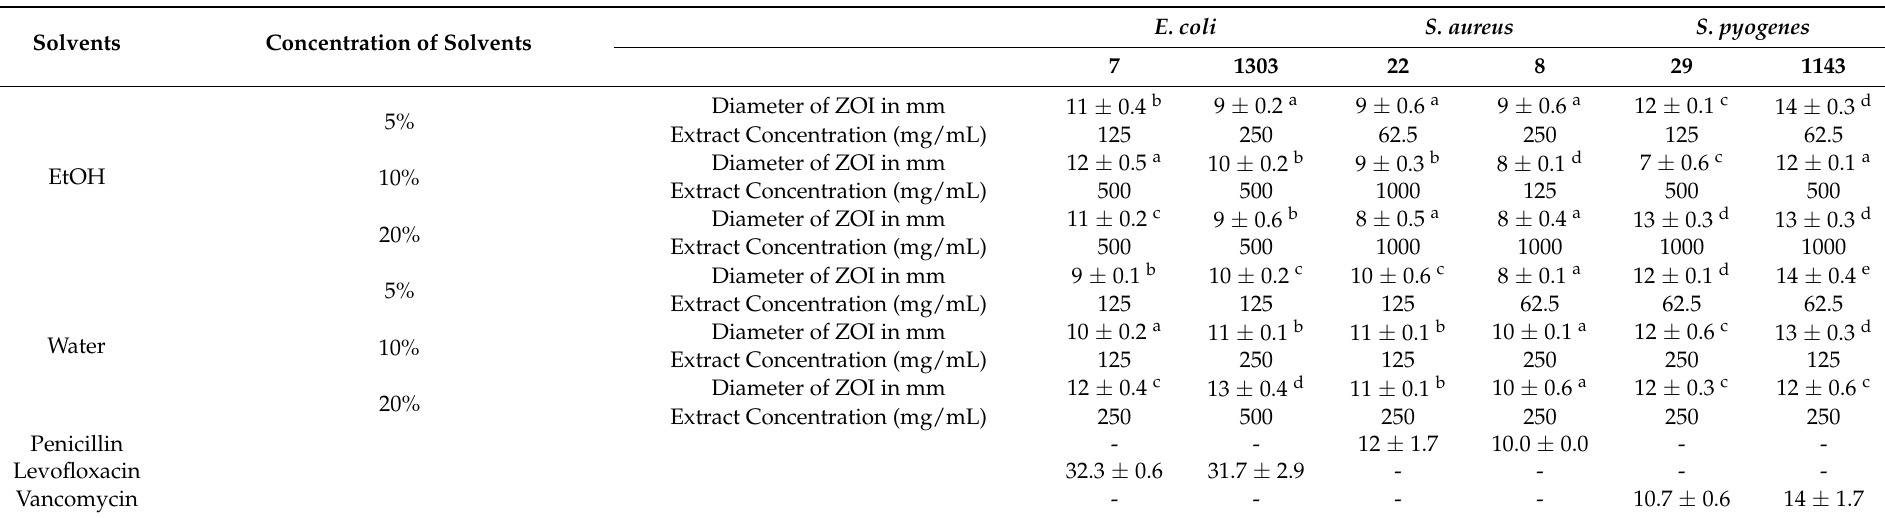
Table 1. Zones of inhibition (ZOIs) of cranberry extract against Escherichia coli , Staphylococcus aureus , and Streptococcus pyogenes .